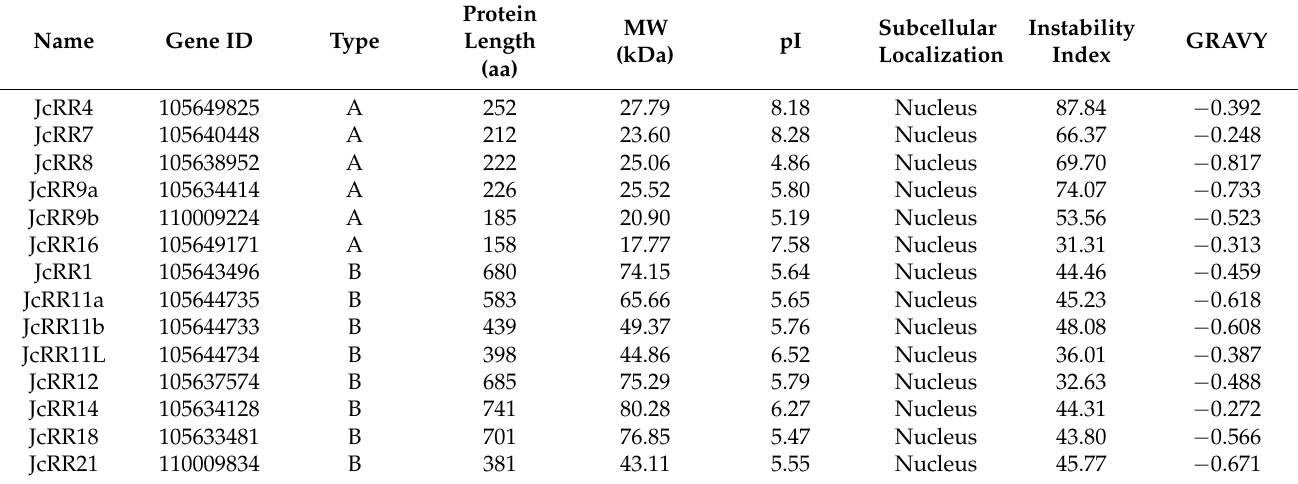
Table 1. Features of cytokinin response regulators in J. curcas . GRAVY, grand average of hydropathic- ity. kDa, kilodaltons.